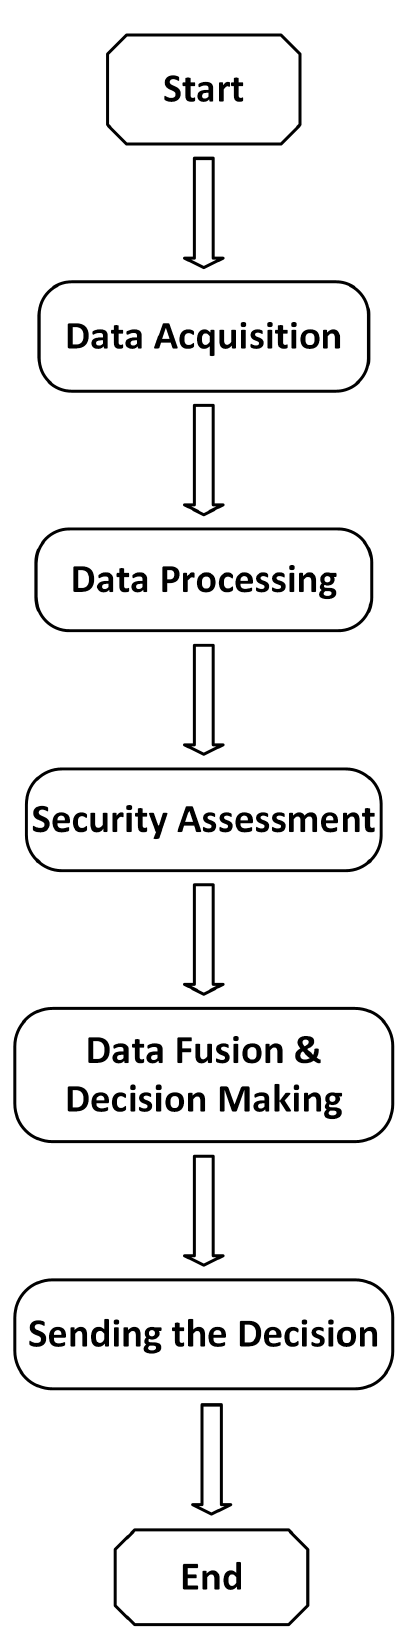
Figure 7. Operating